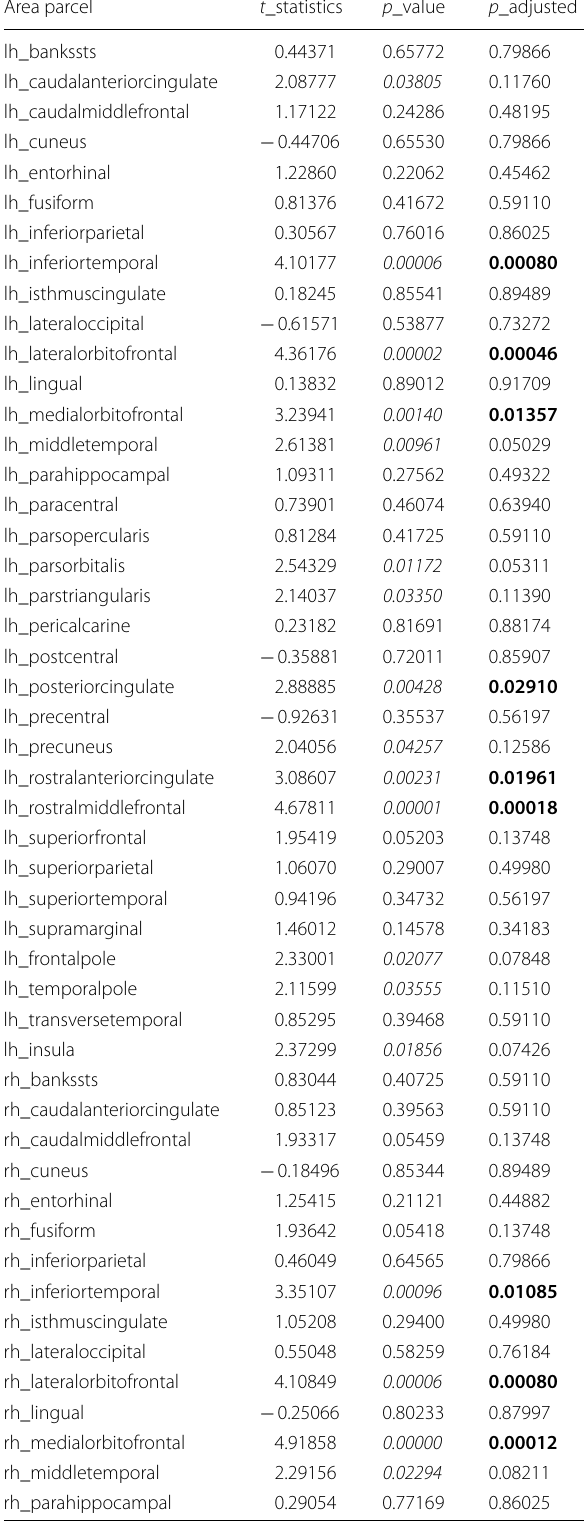
Table 2 Relations between cortical surface area and structural MRI quality (as measured by the CAT12 Toolbox) Area